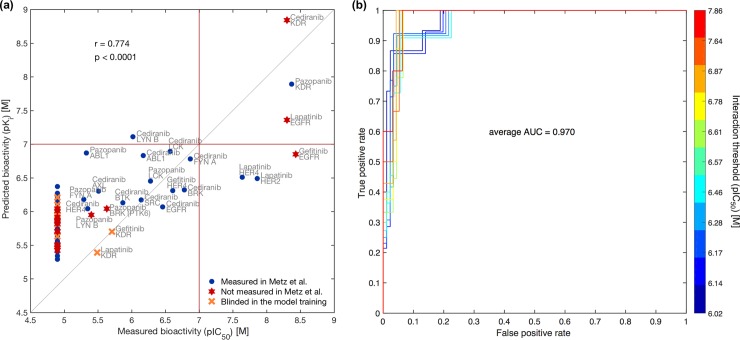
Comparison between computationally-predicted and experimentally-measured bioactivities.(a) Scatter plot between bioactivity values of 100 compound-kinase pairs (detailed in S2 Table). r indicates Pearson correlation. The orange cross points correspond to compound-kinase pairs tested in the study of Metz et al. but randomly blinded by us in the training of the model, forming an additional validation set. When no clear interaction between compound and kinase was observed in our experimental assay, the pIC50 value was set to 4.9 M, corresponding to the highest drug concentration used in our screen (12,500 nM). The higher the pKi/pIC50 value, the stronger the affinity between the two molecules. Red lines mark a relatively stringent interaction threshold (7 M), distinguishing the top left corner as the region containing false positive interaction predictions, and the bottom right corner as false negative predictions. (b) A set of receiver operating characteristic (ROC) curves to investigate the model performance as a function of varying activity threshold. We applied 11 different interaction threshold values from the pIC50 interval [6 M, 8 M] to binarize the experimentally-measured bioactivities into true class labels, and then determined how accurately the model can discriminate between the interacting and non-interacting compound-kinase pairs. The average area under the ROC curves (AUC) equals 0.970.